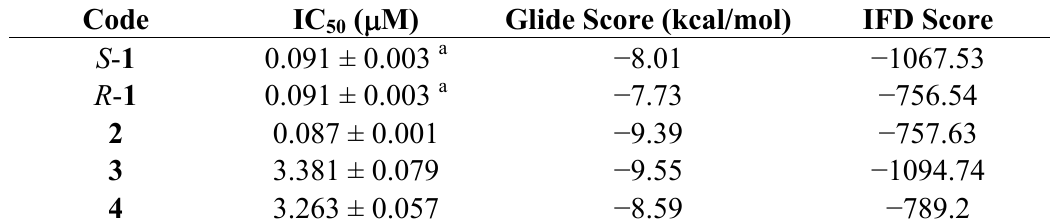
Table 2. Selected docking solutions of compounds along with energetic scores (Glide and IFD